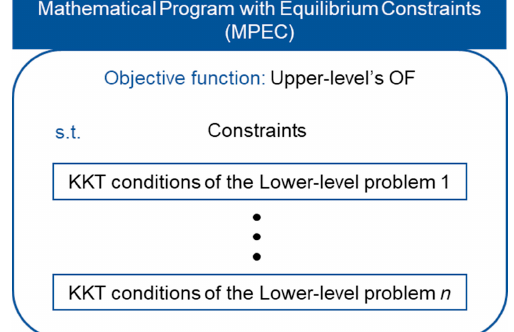
Figure 2. Bi-level framework of strategic agent’s behavior.